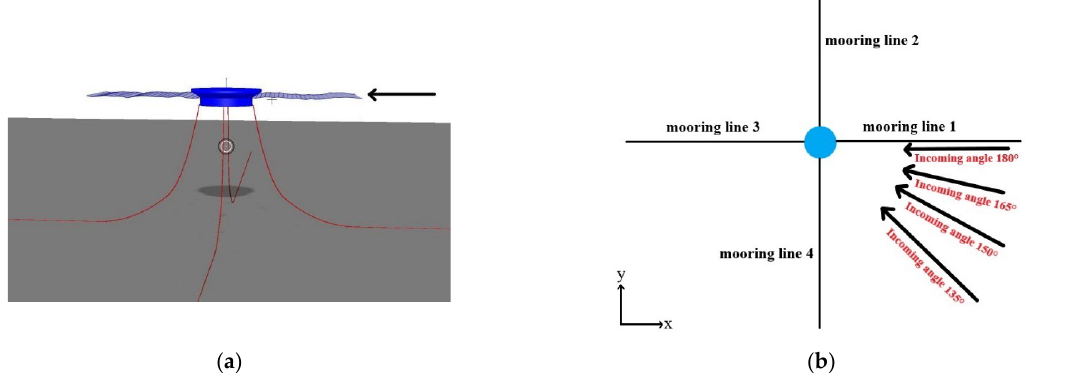
Figure 13. Influence of load direction on mooring system. ( a ) The coupled system for analysis; ( b ) schematic diagram of different load directions.